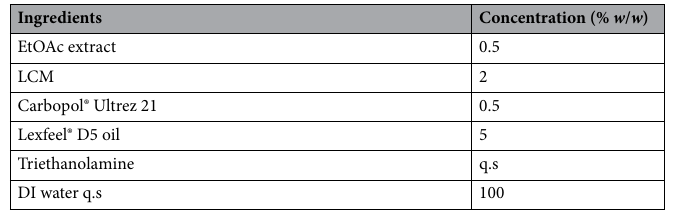
Table 9. Formulation of LLC containing black D. longan seed extracts. EtOAc extract: black D. longan seed ethyl acetate extract; LCM: Liquid Crystal Cream Maker (sorbitan stearate and sucrose cocoate);